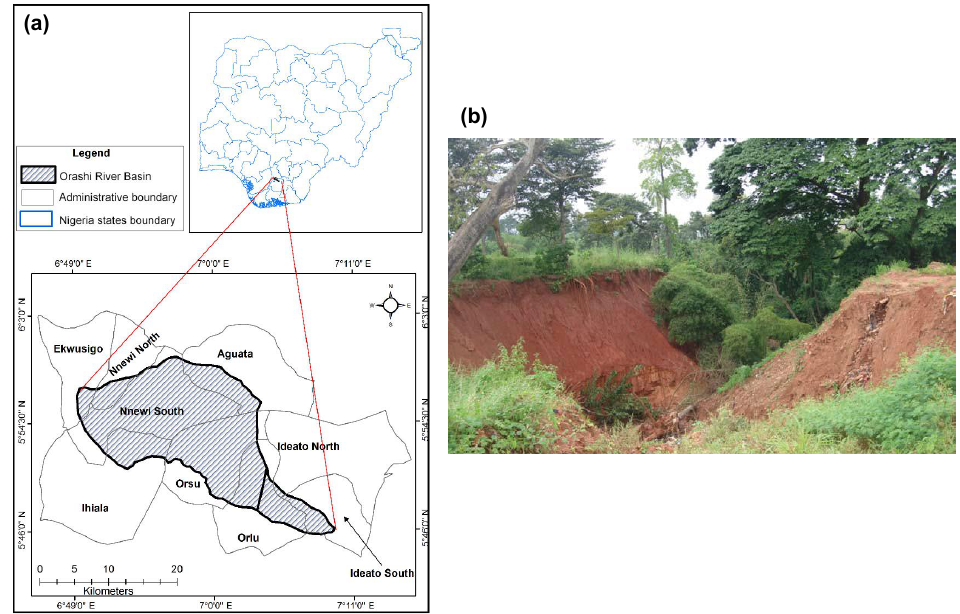
Figure 1. (a) Location of study area, Nigeria map inset. (b) View of eroded land within the study area. Table 1. Data sources, characteristics and processes. Data Characteristics Scale Source Topographic map Sheet 312 SE (1964) 1 : 50000 Nigerian Federal Survey Sheet 313 NW (1964) Satellite imagery Landsat 4: Bands 7,4,2